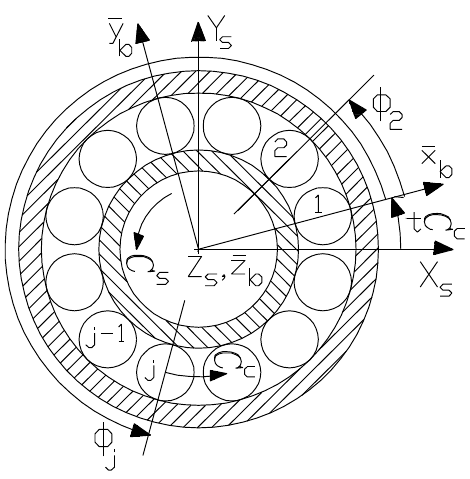
Fig. 2. Ball bearing elements and coordinate